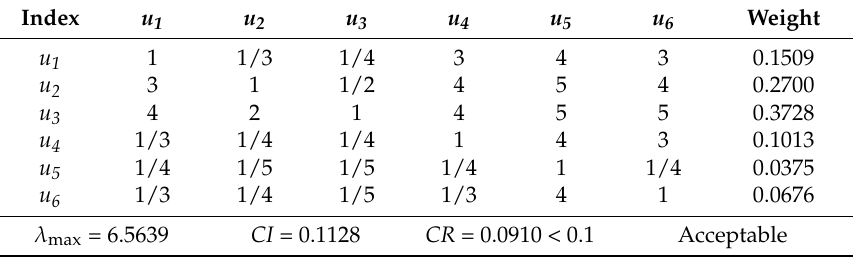
Table 5. Matrix construction and weight calculation of indices associated with the hazard.